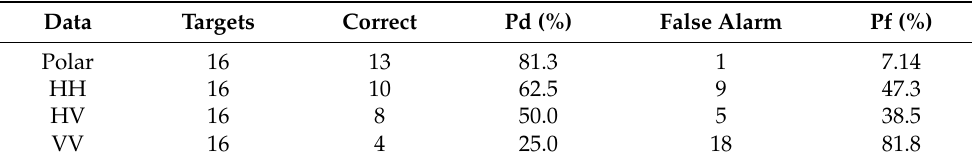
Table 4. Performance comparison of the proposed method using quad-polarization and three single- polarization channels data in Singapore, where Polar denotes quad-polarization data, and HH, HV, VV denote HH, HV, and VV channels,